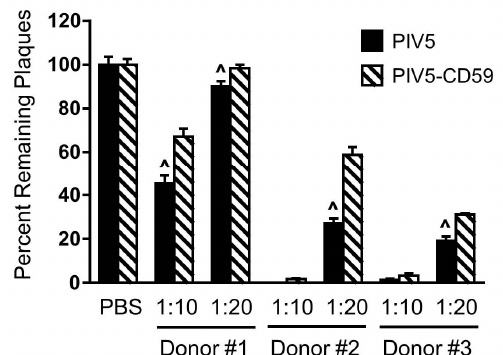
Figure 6. Effect of CD59 on NHS neutralization of PIV5. One hundred PFU of PIV5 derived from control CHO cells (PIV5) or CHO-CD59 cells (PIV5-CD59) was incubated with NHS from the indicated donors at a dilution of 1:10 or 1:20 for 1 h. The remaining infectivity was determined by using the plaque assay. The data are from three independent reactions and error bars represent standard deviation. ^ p < 0.01 when comparing a virus derived from CHO-CD59 cells to a virus derived from CHO control cells.